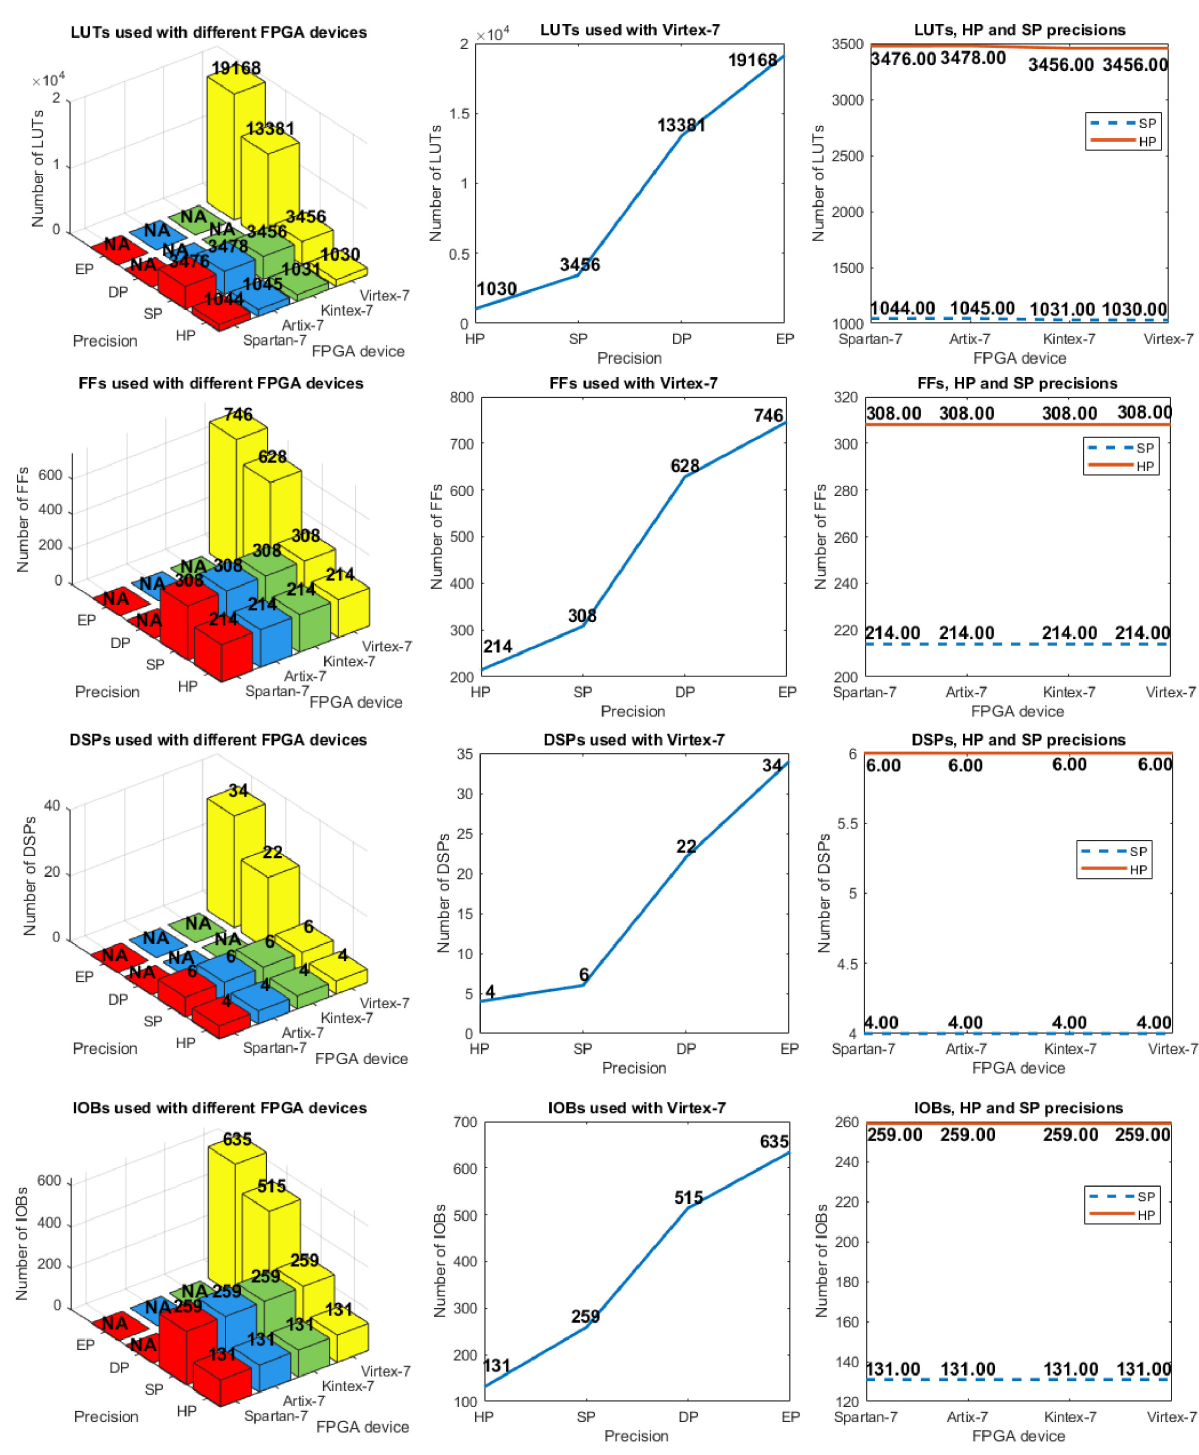
Fig 4. (left) LUTs, FFs, DSPs, and IOBs used with different FPGA devices and precision levels (these are presented in inverse order for better visualization); (center) Similar analysis with Virtex-7 FPGA with different precision levels; (right) Similar analysis for the comparison of precision with HP and SP using different FPGA